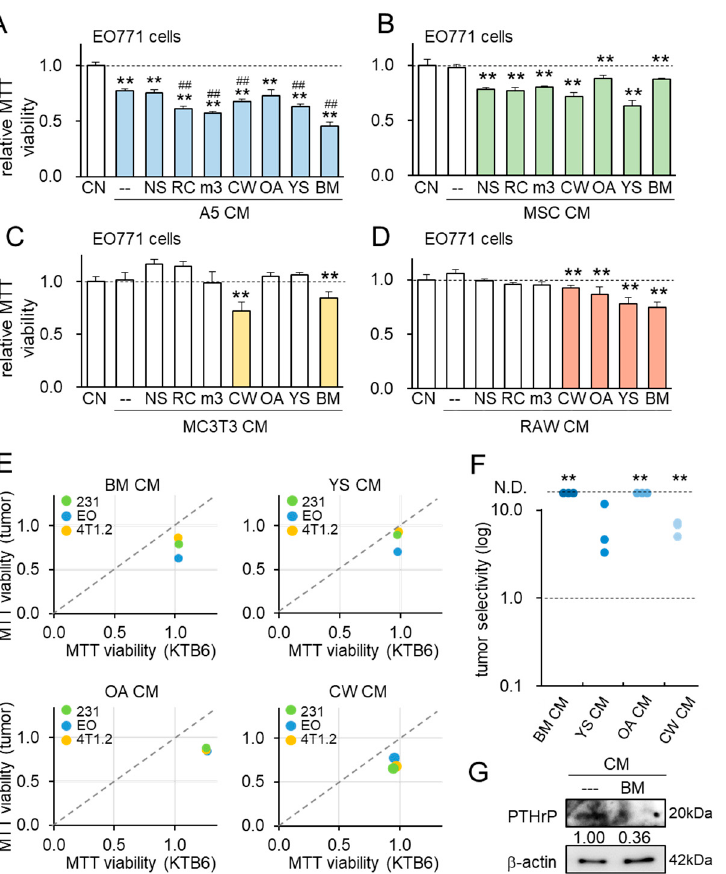
Figure 2. Conversion of RAW264.7 pre-osteoclasts into iTS cells by the treatment with BML284. CN = control, CM = conditioned medium, RAW = RAW264.7 osteoclasts, MC3T3 = MC3T3 osteoblasts, MSC = mesenchymal stem cells, A5 = MLO-A5 osteocytes, 231 = MDA-MB-231 breast cancer cells, EO = EO771 mammary tumor cells, and 4T1.2 = 4T1.2 mammary tumor cells. ** p < 0.01 vs. CN, while ## p < 0.01 vs. A5 CM. ( A – D ) MTT-based viability of EO771 mammary tumor cells in response to a chemically treated conditioned medium, derived from MLO-A5 osteocytes, MSCs, MC3T3 osteoblasts, and RAW264.7 osteoclasts, respectively. NS = NSC228155 (EGF activator), RC = RCGD423 (JAK/STAT activator), m3 = m-3M3FBS (phospholipase C activator), CW = CW008 (PKA activator), OA = OAC2 (Oct4 activator), YS = YS49 (PI3K activator), and BM = BML284 (Wnt activator). ( E , F ) Tumor selectivity of the inhibitory action of RAW CM, examined tumor selectivity of the inhibitory action using 3 tumor cell lines (MDA-MB-231 breast cancer cell line using 3 tumor cell lines (MDA-MB-231 breast cancer cell line, EO771 mammary tumor cell line, and 4T1.2 mammary tumor cell line), and KTB6 human breast epithelial cells. ( G ) Reduction in PTHrP in BM CM.